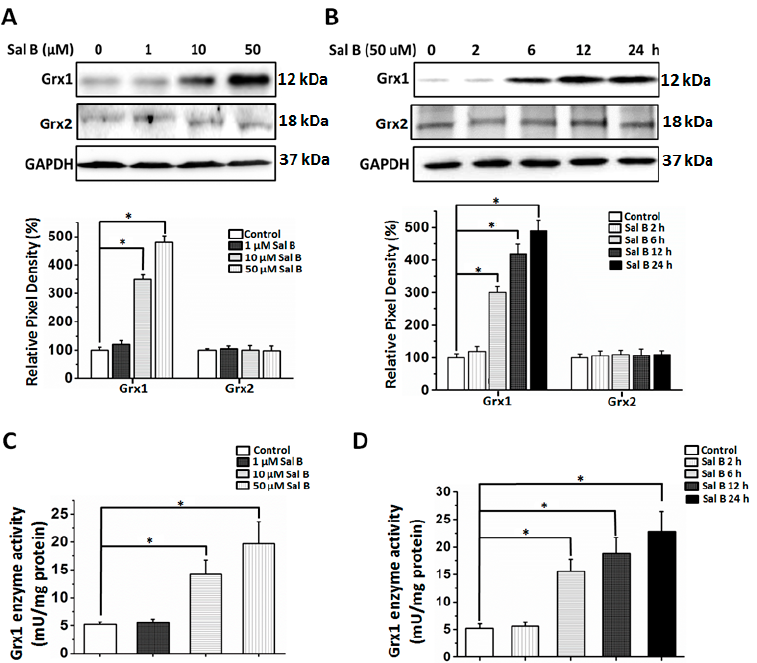
Figure 5. Sal B up-regulates Glutaredoxin 1 (Grx1) but not Grx2 in RPE cells. ( A ) Dose-dependent effects of Sal B on Grx1 and Grx2 expressions. RPE cells were treated with (1–50 μ M) Sal B for 24 h. Control cells were treated identically but without addition of Sal B. Bottom panel: The relative pixel density of Grx1 and Grx2 over glyceraldehyde 3-phosphate dehydrogenase (GAPDH). * p < 0.05 compared with the control group ( n = 3); ( B ) time-dependent effects of Sal B on Grx1 and Grx2 expression. RPE cells were treated with or without Sal B for 2, 6, 12, and 24 h. Bottom panel: The relative pixel density of Grx1 and Grx2 over GAPDH. * p < 0.05 compared with the control group ( n = 3); ( C ) dose-dependent effects of Sal B on Grx1 enzyme activity. RPE cells were treated with (1–50 μ M) Sal B for 24 h. Control cells were treated identically but without addition of Sal B. * p < 0.05 compared with the control group ( n = 3); and ( D ) time-dependent effects of Sal B on Grx1 enzyme activity. * p < 0.05 compared with the control group ( n = 3).